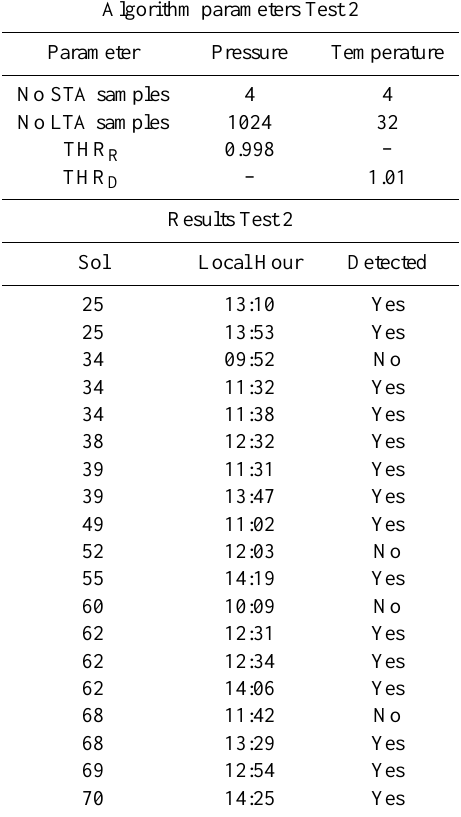
Table 4. Test 2. Dust devils detected each sol. Algorithm parameters Test